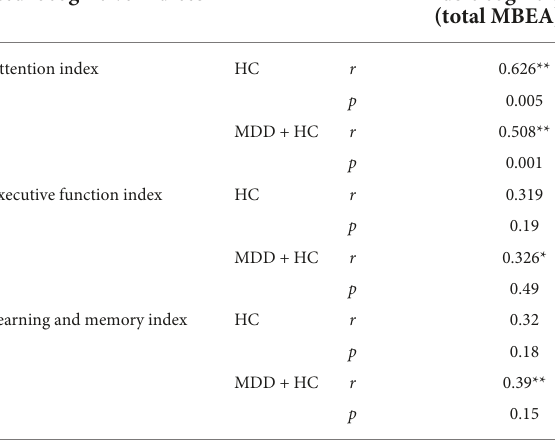
TABLE 7 Spearman’s rho between Neurocognitive indices and music cognition. Neurocognitive indices Music cognition